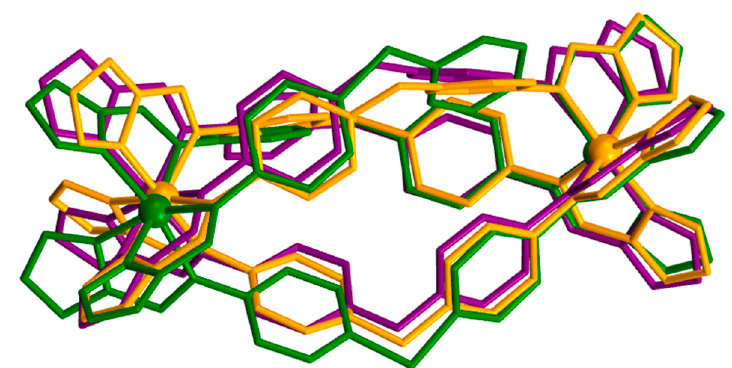
Figure 3. Schematic overlay representation of the X-ray structures of 1 (orange), 2 (green) and 3 (purple) at 100 K. Counter Ions, solvent molecules and hydrogen atoms have been excluded for clarity.